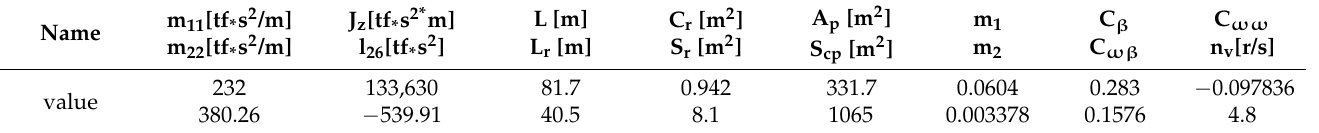
Table 1. Movement model parameters of Equation (1) of the Volgo-Balt type